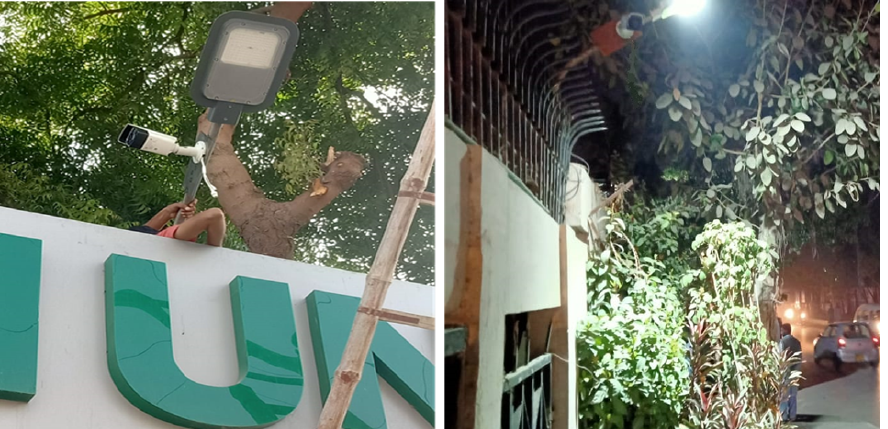
Figure 3. Experimental setup at the selected